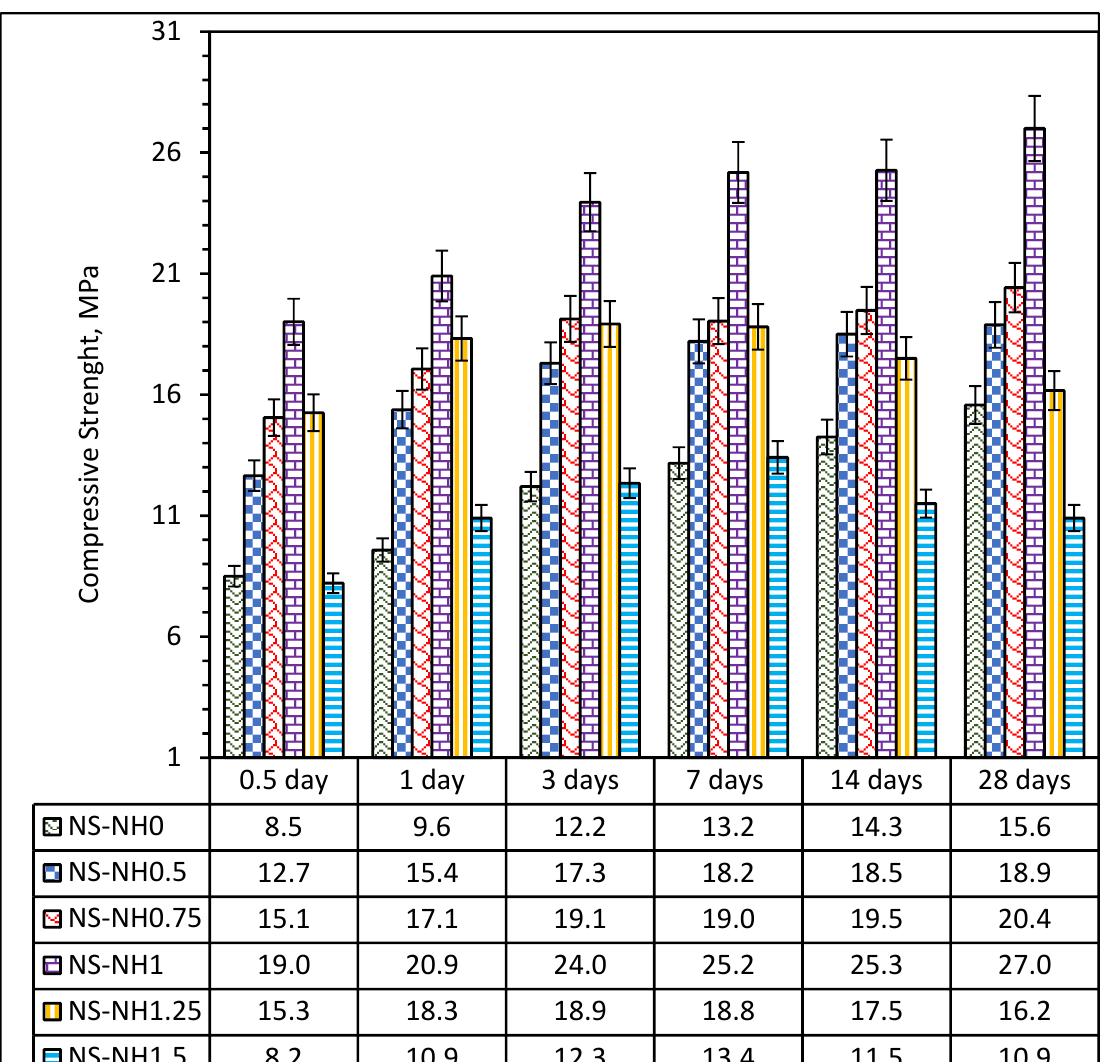
Figure 6. Compressive strength of AANL mixes with varying silica modulus.